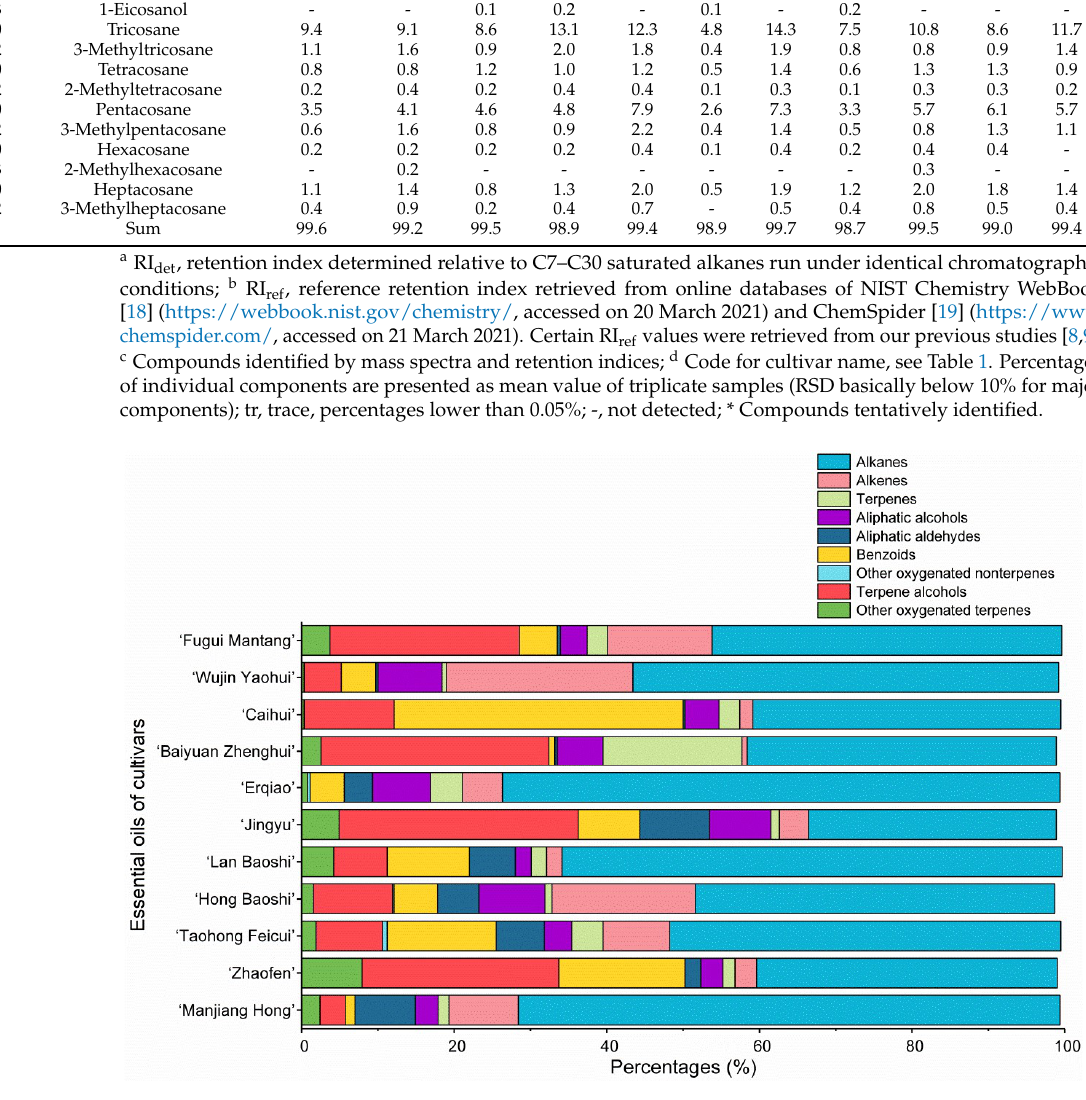
Figure 3. Group chemical components of flower essential oils of the eleven woody peony cultivars ( Paeonia × suffruticosa Andr.).